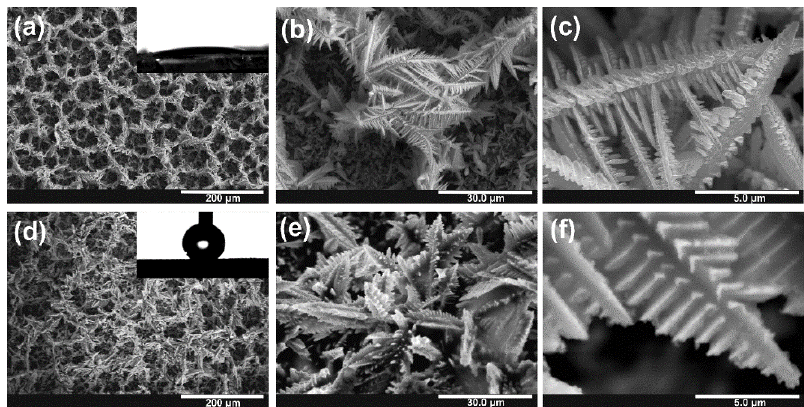
Figure 1. Field-Emission Scanning Microscope (FE-SEM) images of the nanoporous Sn foam obtained by electrodeposition for 60 s in acidulated 20 mM SnCl 2 · 2H 2 O at the potential of 6 V. As-obtained ( a – c ) and annealed in air at 200 °C for 2 h ( d – f ). Insets in a and b —images of water droplets just after placing on the particular surface.